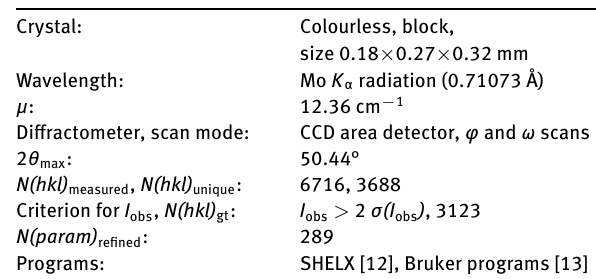
Table 1: Data collection and handling.